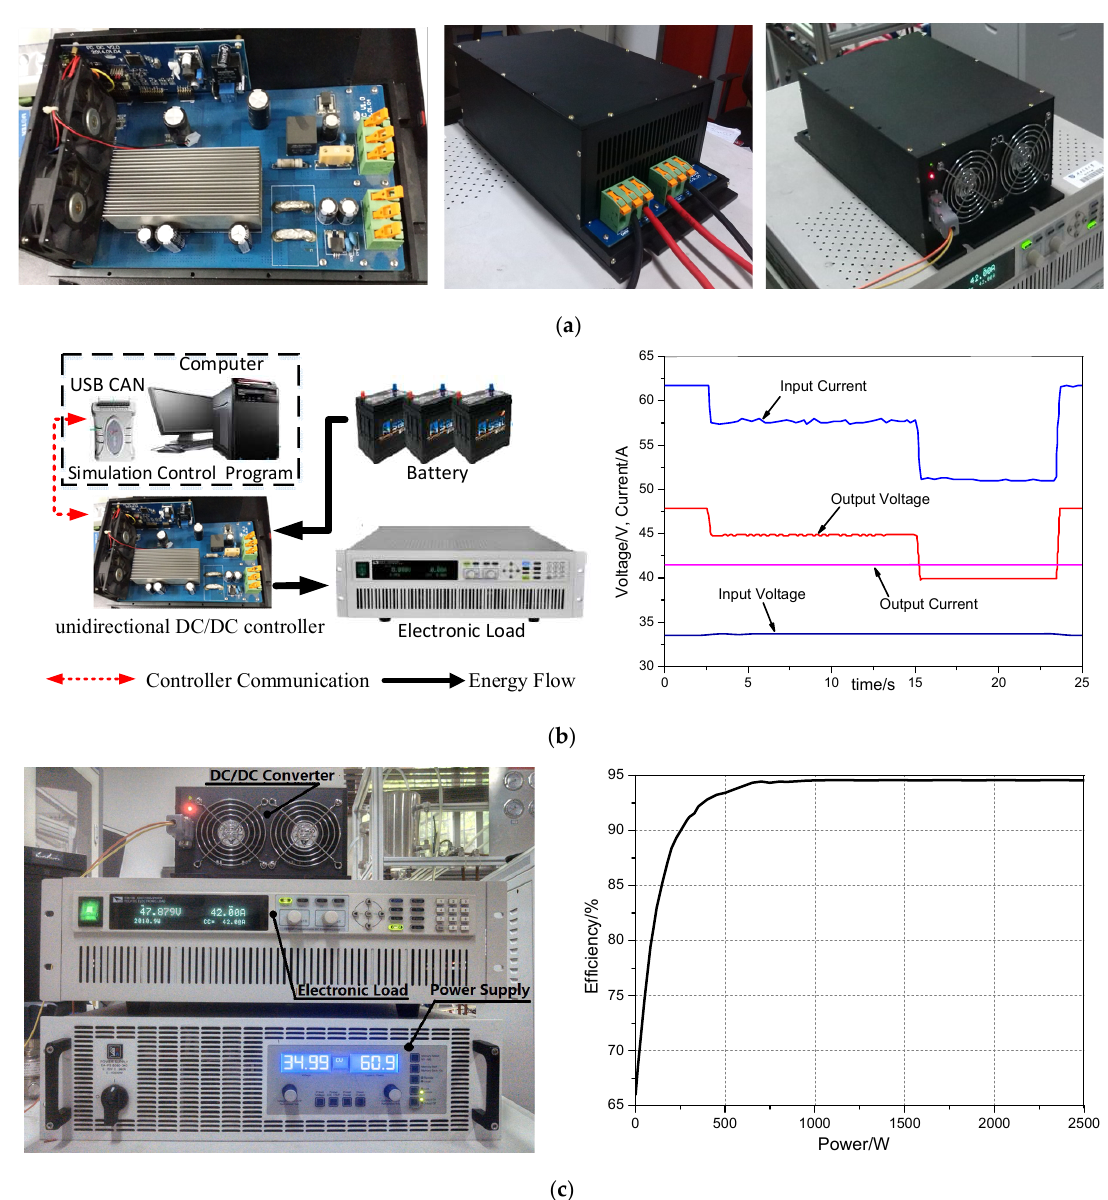
Figure 8. Unidirectional buck-boost DC/DC converter. ( a ) Prototype of the DC/DC converter. ( b ) Program control and response test. ( c ) Efficiency test.